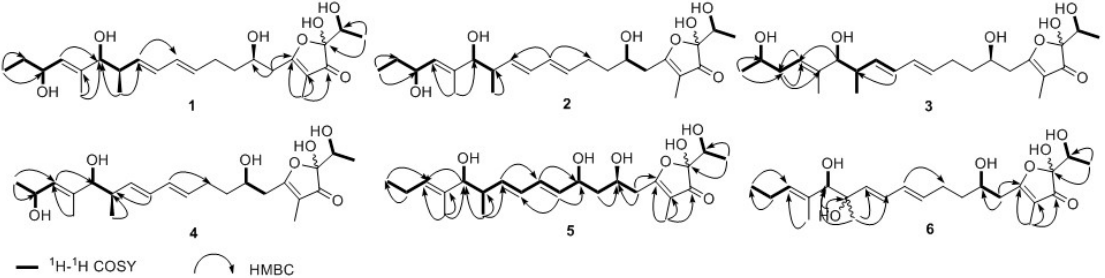
Figure 2. 1 H- 1 H COSY and key HMBC correlations for compounds 1 – 6 .